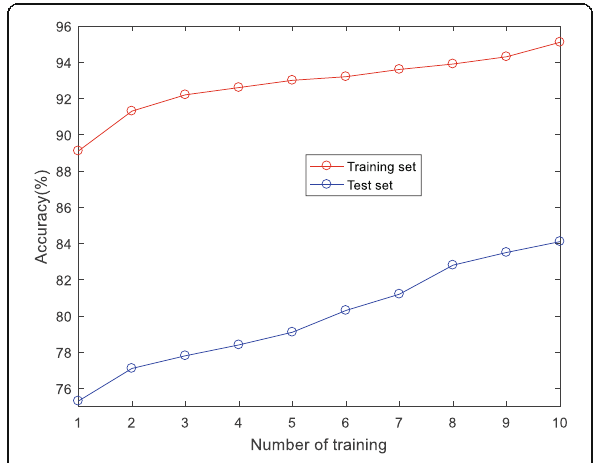
Fig. 6 Experimental results of mixed model classification